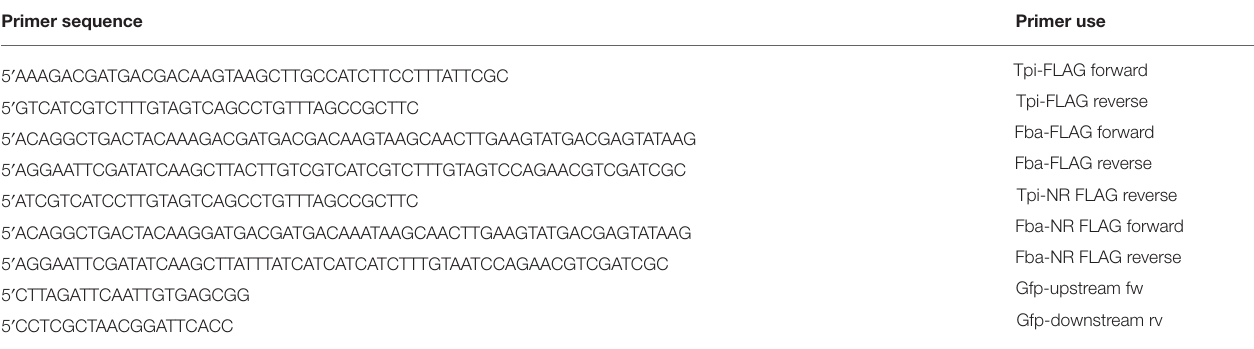
TABLE 1 | Primers used for construction of pRL pfkA_tpi_fbaA and pRL pfkA_tpi_fbaA ′ plasmids bearing identical or unique FLAG sequences, respectively. Primer